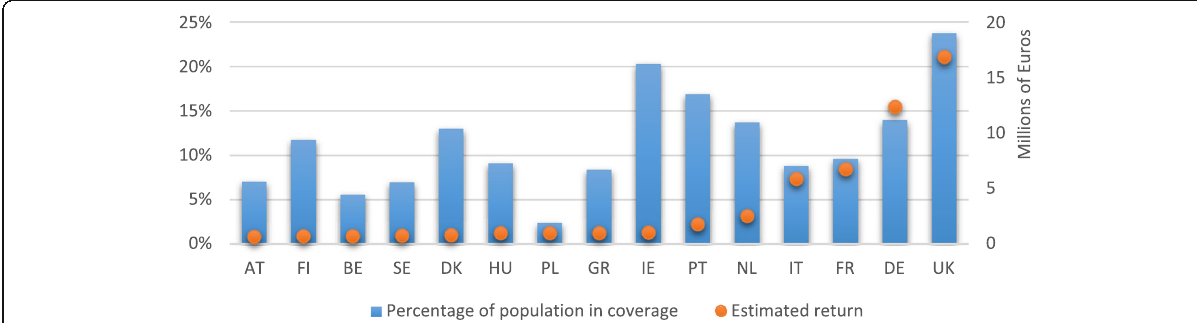
Fig. 13 Percentage of population covered by drone service (left axis) and estimated return of drone delivery hives per country (right axis) for Scenario 2 conditions and a 650.000-euro economic viability